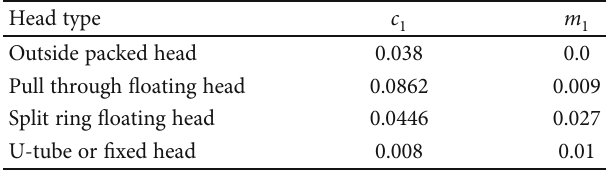
and m for use in equation (9) 1 1